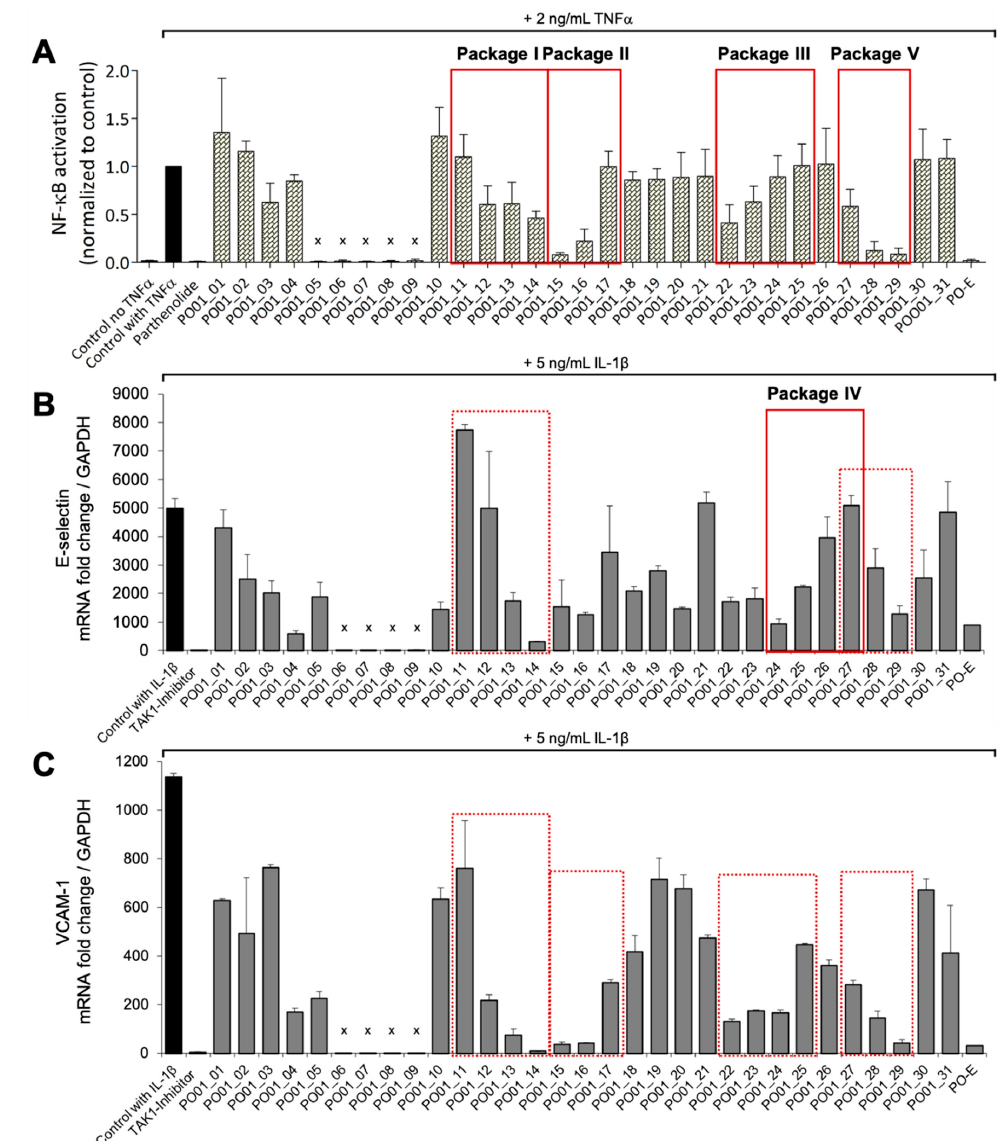
Figure 2. Bioactivity data of PO01_01–PO01_31 in (A) an NF- ĸ B reporter-gene assay, a real-time PCR analysis of (B) E-selectin and (C) VCAM-1. Packages I–V are shown as red squares (solid lines, bioactivity data used for HetCA analysis; dotted lines, packages for comparison of bioactivity data); ( A ) PO01_01–PO01_31, the crude extract PO-E (all 10 µ g / mL) and the positive control parthenolide (10 µ M) were tested in a cell-based in vitro NF- κ B-driven luciferase reporter assay in HEK293–NF- κ B-luc cells stimulated with 2 ng / mL TNF α as indicated. The luciferase signal derived from the NF- κ B reporter was normalized to the CTG-fluorescence and expressed as fold change normalized to the vehicle control (DMSO 0.1%) with TNF α . Bar charts represent (residual) NF- κ B transactivation activity expressed as mean ± SD, n = 3. Microfractions marked with an “x” showed cytotoxicity; ( B ) PO01_01–PO01_31, the crude extract PO-E (all 50 µ g / mL), the positive control TAK1-inhibitor (5 µ M (5Z)-7-oxozeaenol) and vehicle control (DMSO 0.5%) were assayed for E-selectin expression in primary human venous endothelial cells (HUVEC). Real-time PCR of cDNA obtained from IL-1 β (5 ng / mL, 90 min)-stimulated HUVEC which were either untreated (DMSO) or pre-treated (30 min) with 50 µ g / mL PO01_01-PO01_31. Relative mRNA levels of E-selectin were normalized to GAPDH and expression levels are depicted as mean fold change ± SD compared to non-stimulated cells. n = 3. Microfractions marked with an